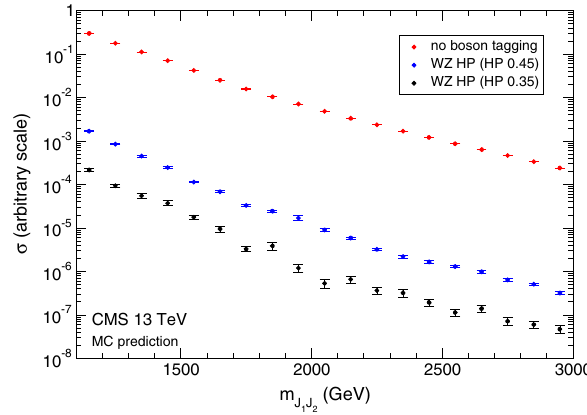
Fig. 15 Monte Carlo predictions for the QCD dijet background, with the event selection for the CMS Run 2 hadronic diboson searches. The red line corresponds to the topological selection, and the blue and black lines to the W Z HP selection defining HP jets as those with τ 21 ≤ 0 . 45 or τ 21 ≤ 0 . 35, respectively. The error bars in the points represent the Monte Carlo